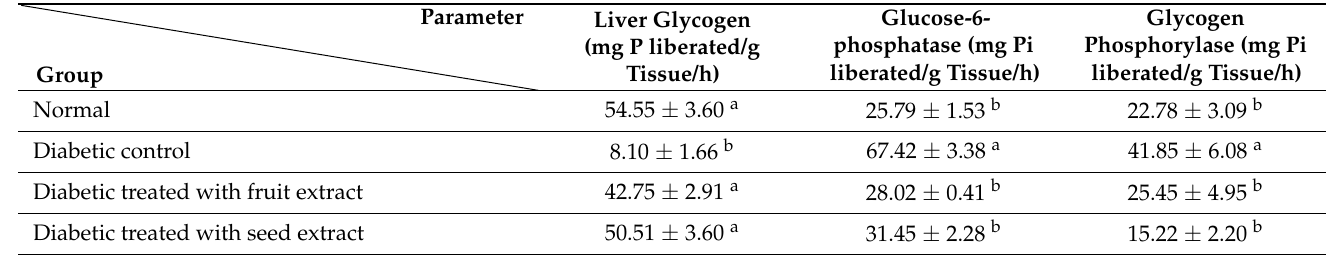
Table 5. Effects of the B . aegyptiaca fruit and seed extracts on liver glycogen content and glucose-6-